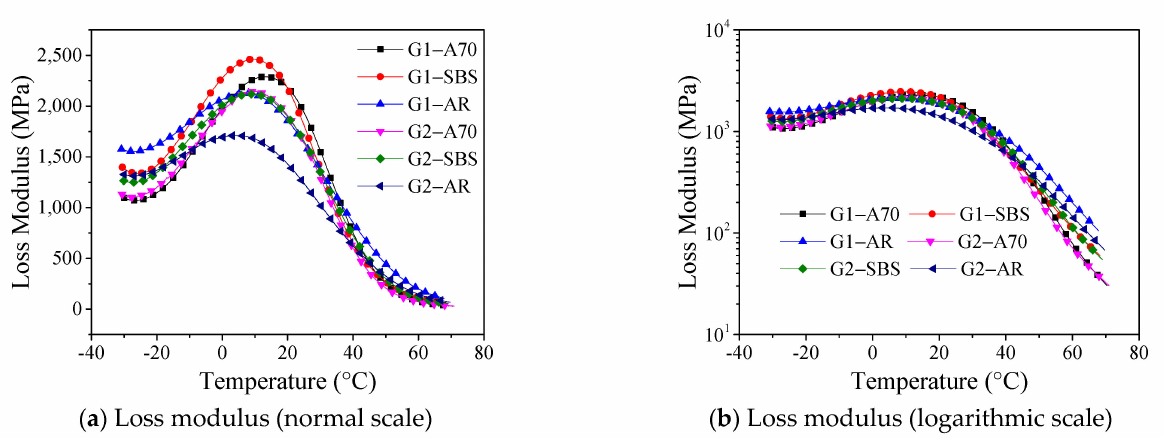
Figure 7. Loss modulus curve (normal and logarithmic scales).